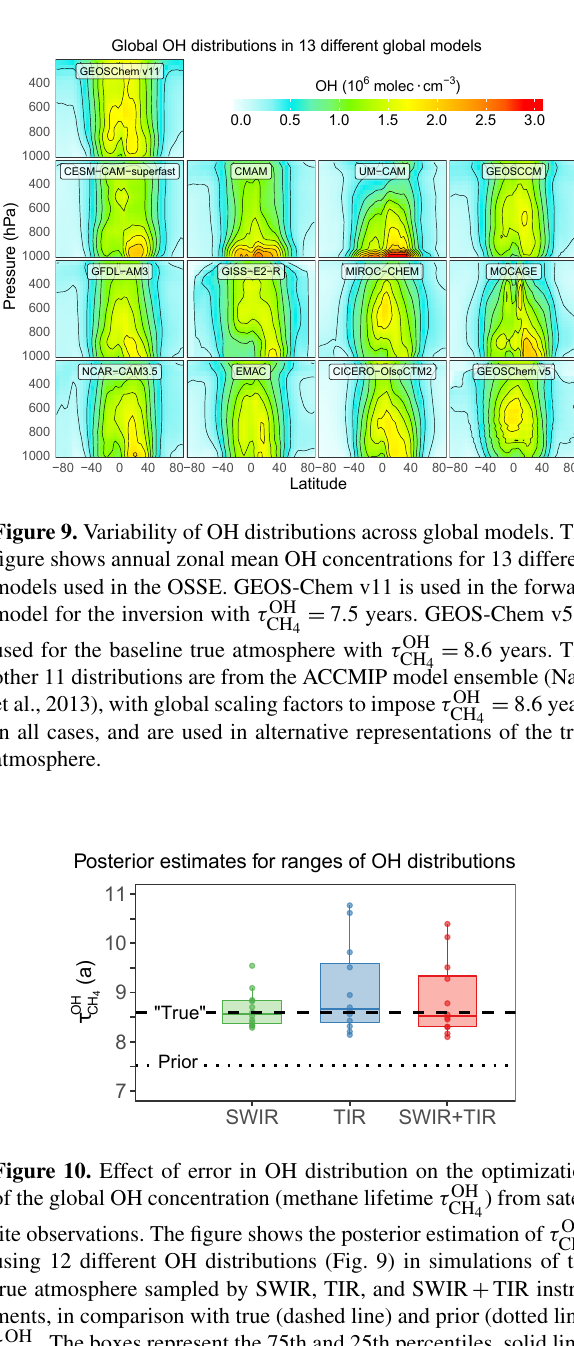
) from satel- CH 4 CH 4